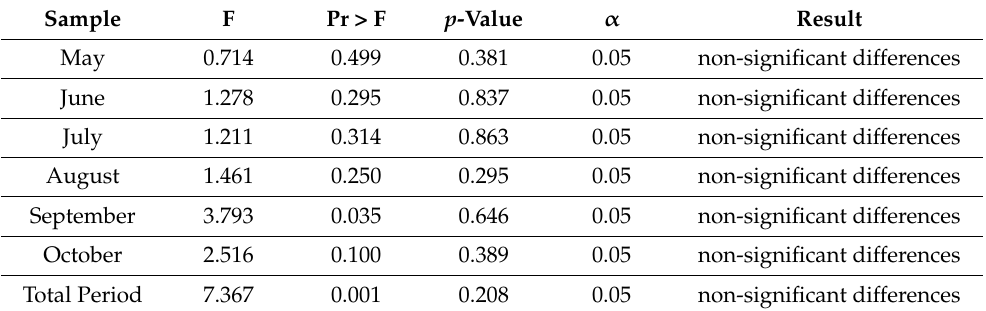
Table 2. Results of the analysis of variance (ANOVA) among BBMC%, BMMC% and LFMC%.